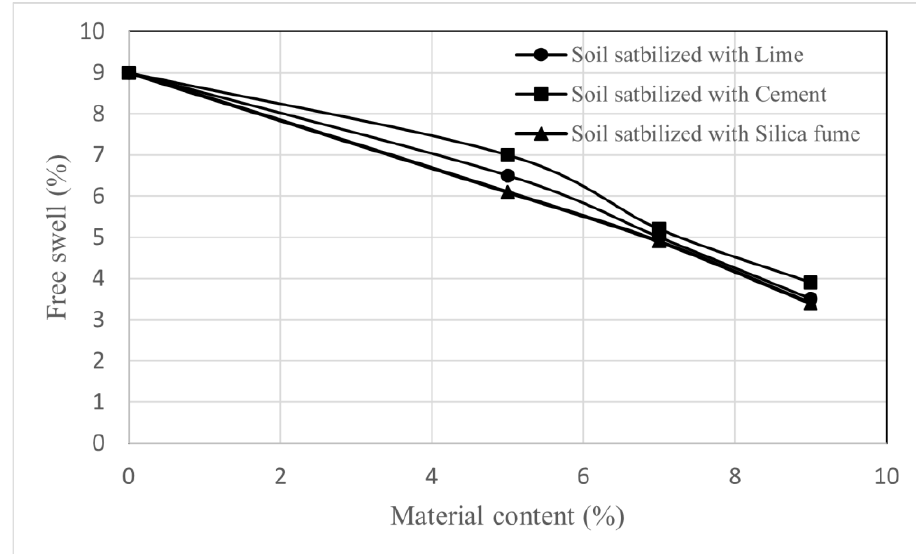
Figure 6. Free swell for different percentages of additives.